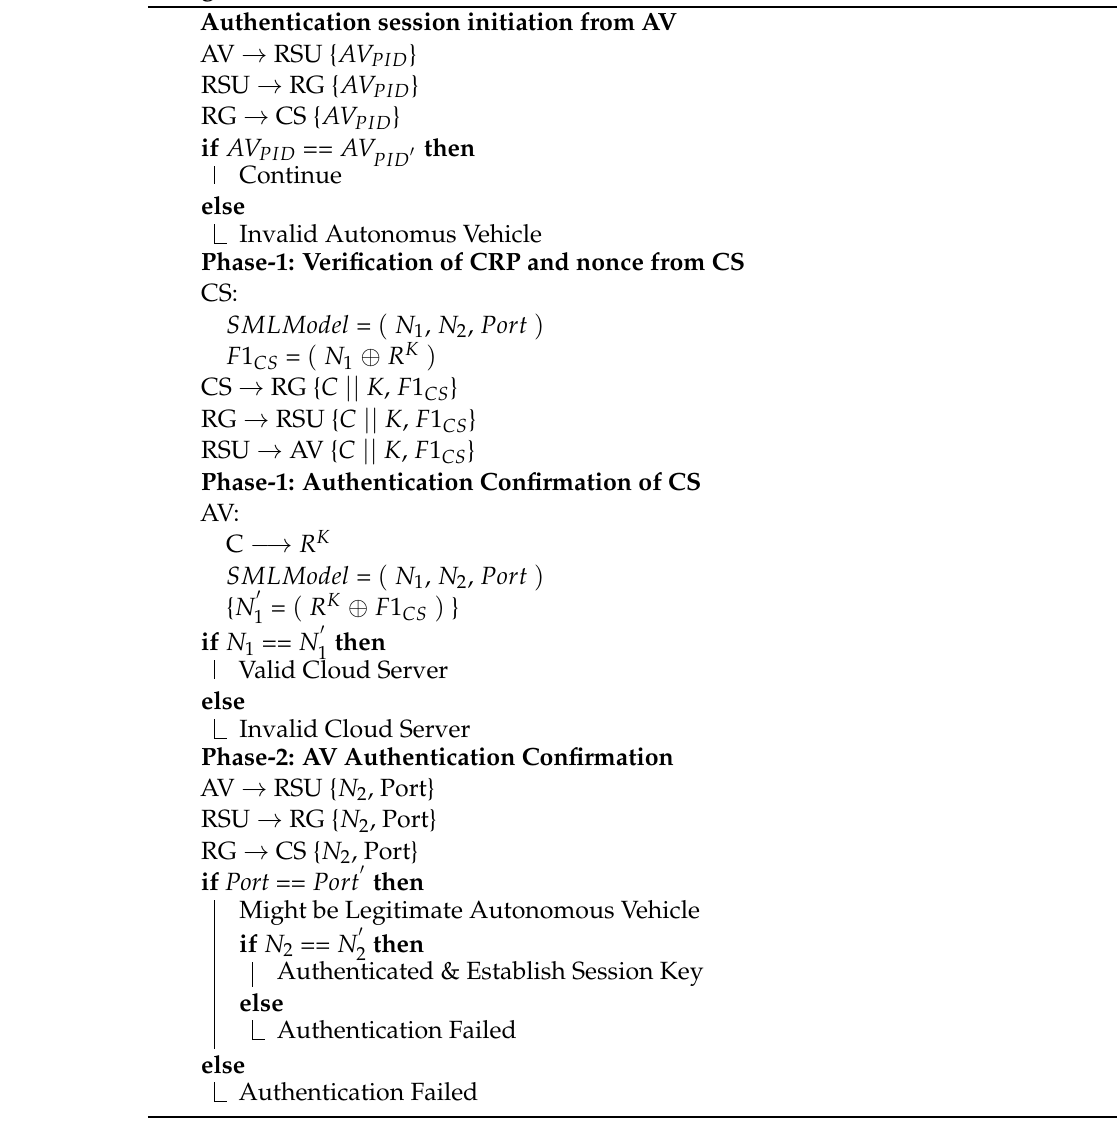
Algorithm 1: Secure Authentication